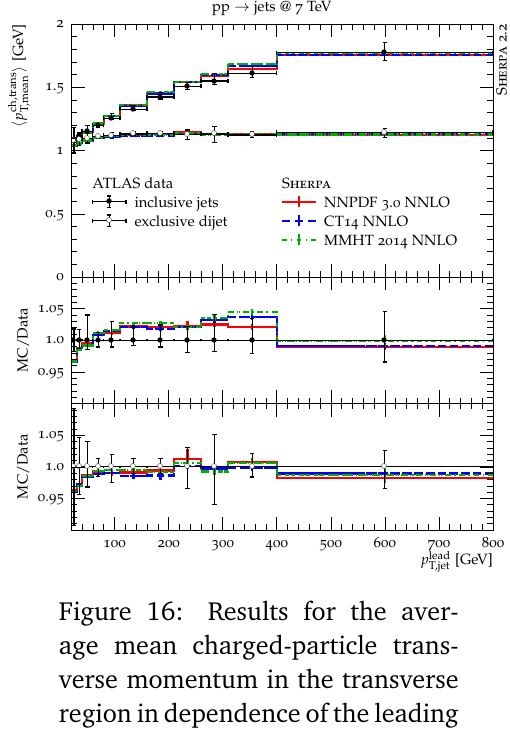
Figure 15: Results for the differen- tial jet shape ρ ( r ) in dependence on the jet transverse momentum within | η | < 2.8 in comparison to A TLAS data [ 195 ] .